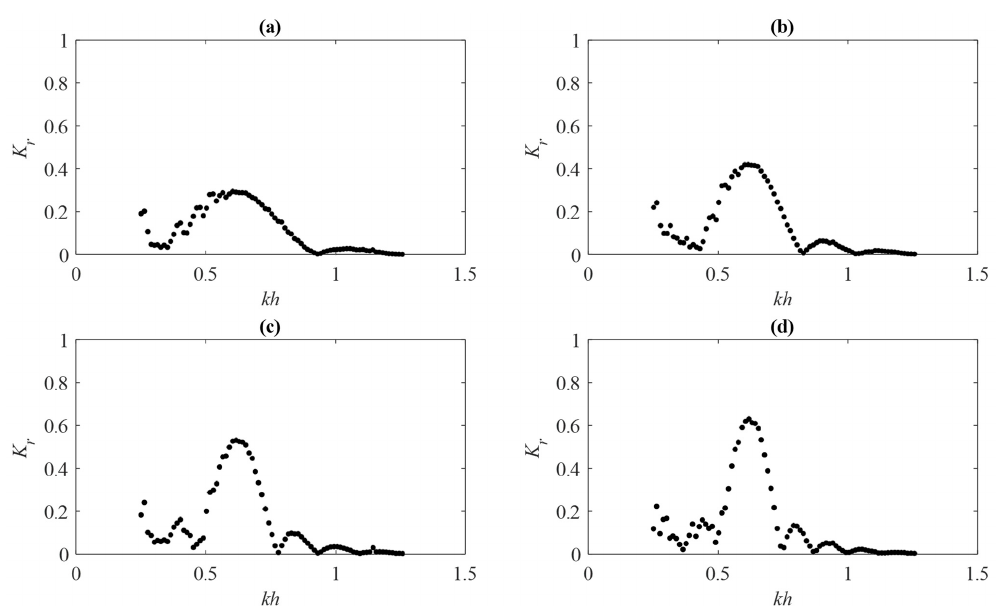
Figure 11. Reflection coefficient of multiple periodically submerged breakwater with 1.0 m wave- length at 0.2 m water depth: ( a ) 𝑁 = 2 ( b ) 𝑁 = 3 ( c ) 𝑁 = 4 ( d ) 𝑁 = 5 .